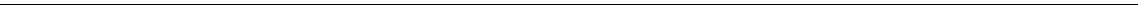
Figure 3 | 3 0 -UTR of PpCSP1 gene has a universal degradation function. ( a ) Location of 5 0 -end of PpCSP1 and PpCSP1-Citrine transcripts in wild-type, nPpCSP1-Citrine-3 0 -UTR and nPpCSP1-Citrine-nosT lines, respectively, detected by 5 0 -DGE transcriptome analysis. Sequence reads of full-length mRNAs were mapped around the transcription start site of the gene, and those of degraded mRNAs were mapped to other region of the transcript. ( b , d ) Bright-field (BF) and sGFP images of an excised leaf of EF1 a pro:sGFP-nosT #3 ( b ) and EF1 a pro:sGFP-3 0 -UTR #18 ( d ) at 0, 24 and 48h after cutting. Several edge and non-edge cells are numbered for c , e , respectively. ( c , e ) The intensity of the sGFP signals in each cell of an excised leaf of EF1 a pro:sGFP-nosT #3 ( c ) and EF1 a pro:sGFP-3 0 -UTR #18 ( e ) (numbers correspond to cells in the top panels of b , d , respectively). Red and black lines indicate the sGFP intensity in cells that were and were not reprogrammed into stem cells, respectively. ( f , g ) Bright-field (BF) and fluorescent images of EF1 a pro:sGFP-nosT #3 ( f ) and EF1 a pro:sGFP-3 0 -UTR #18 ( g ) in protonemata and a gametophore, respectively. ( h ) Schematic representation of the introduced fragments. Series of the PpCSP1 3 0 -UTR with different lengths (yellow boxes) were connected to sGFP (green arrows), which is constitutively expressed by the rice Actin 1 promoter (orange arrows). These deletion constructs were introduced into Physcomitrella leaf cells with mRFP (red arrow) fragments (shown at the top) by particle bombardment. ( i ) Representative cells with mRFP (red) and sGFP (green) signals with constructs shown in h . ( j ) Ratio of sGFP intensity to co-transformed mRFP intensity in each transformed cell ( n ¼ 10). Error bars represent s.d. Scale bars, 50 m m ( b , d , i ); 500 m m ( f , g ). NATURE COMMUNICATIONS|8:14242|DOI: